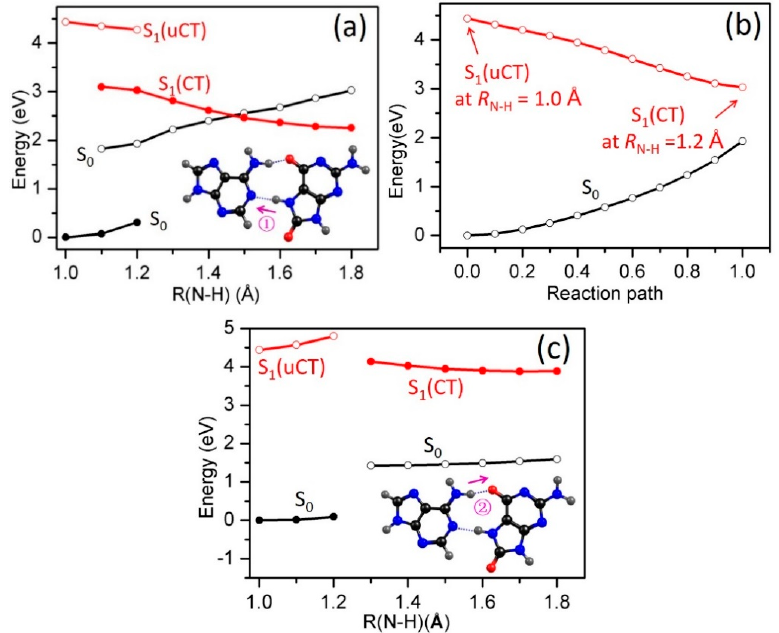
Figure 3. PE profiles of the ground state and the lowest singlet excited states of the HG1 8-oxo-G − -A base pair along R N7 − H13 ( a ) and R N10 − H11 ( c ) proton-transfer coordinates; ( b ) shows the energy profiles of the LIIC path connecting S 1 (uCT) with S 1 (CT) in ( a ).